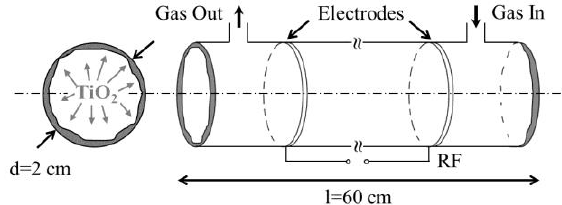
Figure 5. Schematic of the Pyrex tube coated internally with a TiO 2 sol-gel film and TiO 2 nano-particles, with two electrodes, placed outside the tube [51], © IOP Publishing. Reproduced with permission. All rights reserved.